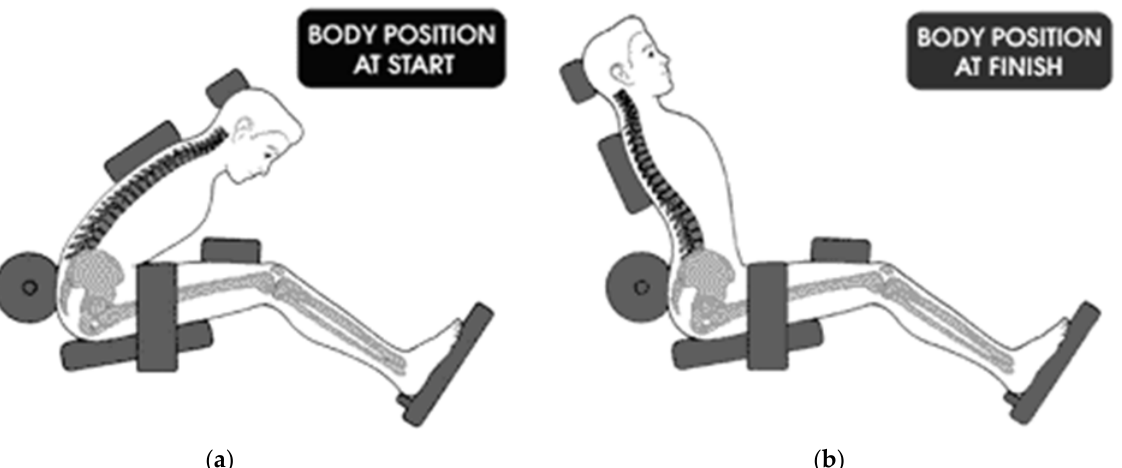
Figure 1. Illustration of pelvic restraint mechanisms and movement patterns on the home back extension exercise device. ( a ) Start position (lumbar flexion). ( b ) Finish position (lumbar extension).